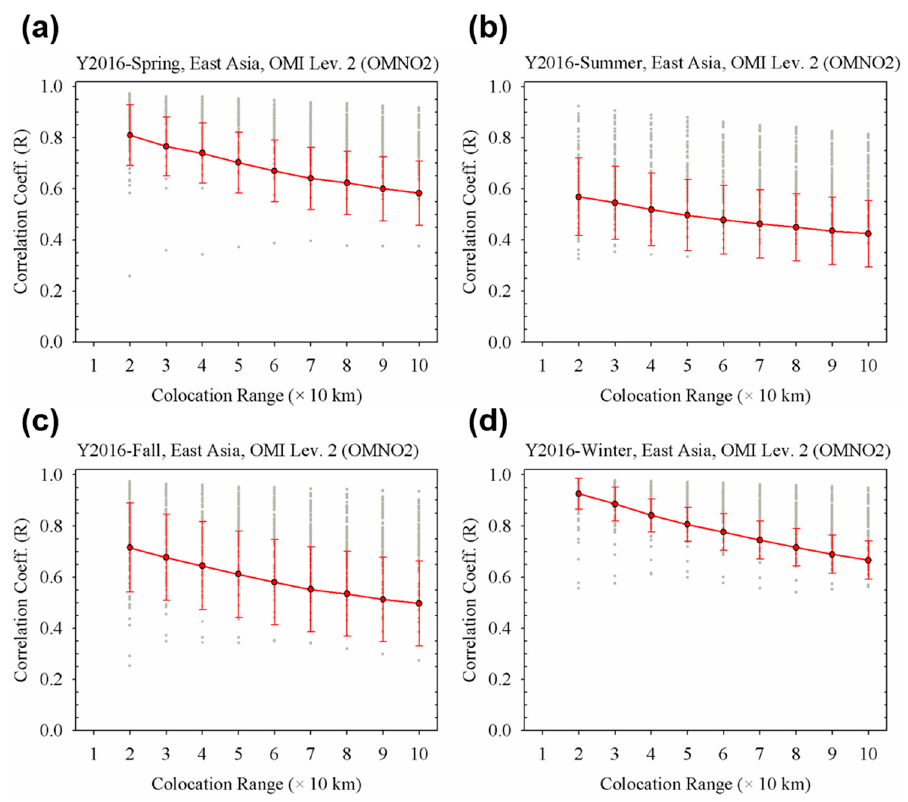
Figure 8. Distribution of correlation coefficient (R d ) for TCN in East Asia with respect to the colocation range in ( a ) spring, ( b ) summer, ( c ) autumn, and ( d ) winter.